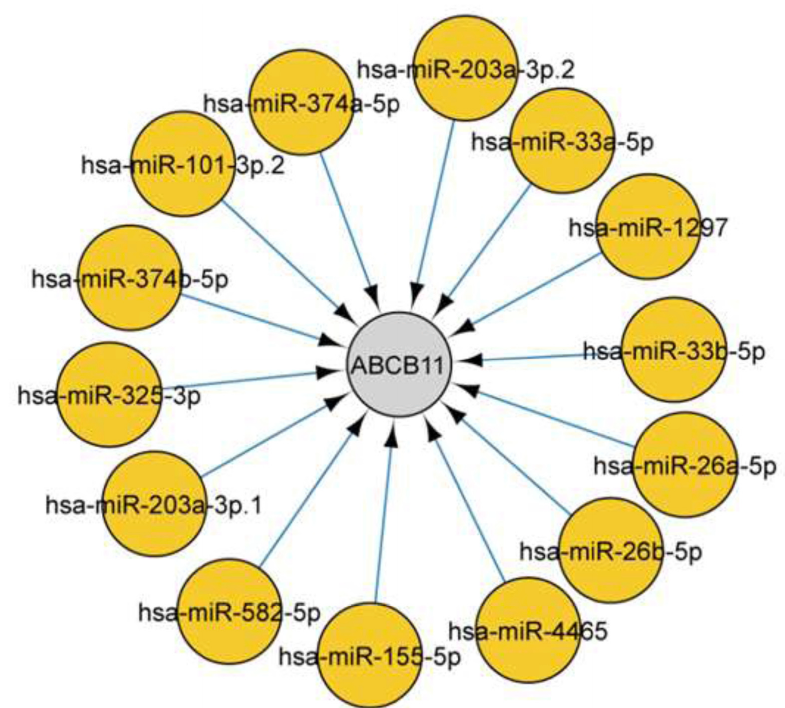
Figure 5. CyTargetlinker was used to screen microRNAs using the Target-scan database. We identified microRNAs that were associated with ABCB11 . In total 14 microRNA identified targeting the gene.